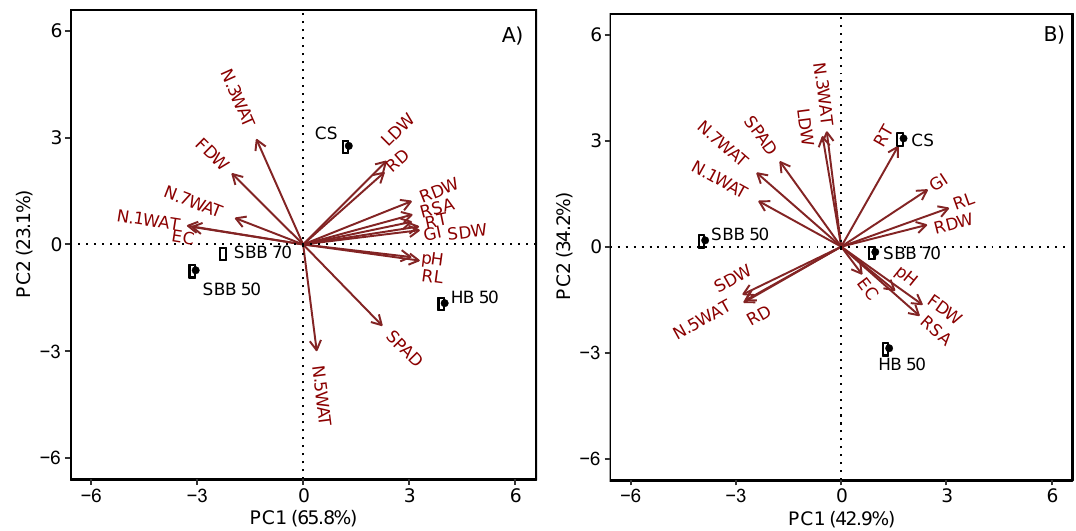
Figure 7. Principal component analysis (PCA) depicting the relationships between selected variables and treatment factors with tomato ( A ) and basil ( B ). Selected variables are displayed by arrows and include plant growth parameters—SPAD, growth index (GI), fruit dry weight (FDW), leave dry weight (LDW), shoot dry weight (SDW), root length (RL), root dry weight (RDW), root diameter (RD), root surface area (RSA), and number of root tips (RT); substrate chemical parameters were pH, EC, and NO 3 –N leachate at different weeks. Treatment factors are displayed by filled grey circles: 50% sugarcane bagasse biochar (SBB 50), 50% mixed hardwood biochar (HB 50), 70% SBB (SBB 70) mixed with bark-based commercial substrate, and bark-based commercial substrate (CS).